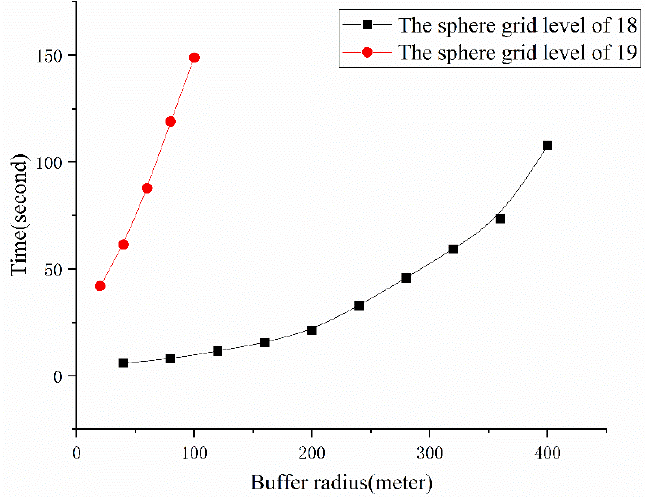
Figure 12. Algorithm efficiency diagrams for a 3D buffer of a point: ( a ) The X-axis represents the buffer radius, and the Y-axis represents the computation time. ( b ) The X-axis represents the square of the buffer radius, and the Y-axis represents the computation time.